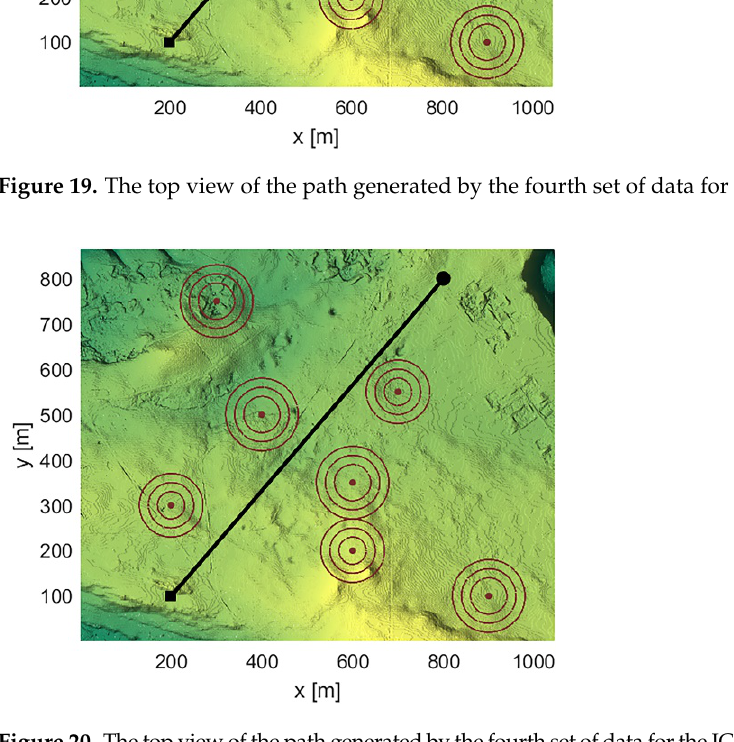
Figure 20. The top view of the path generated by the fourth set of data for the IC-VAINDIWPSO algorithm.